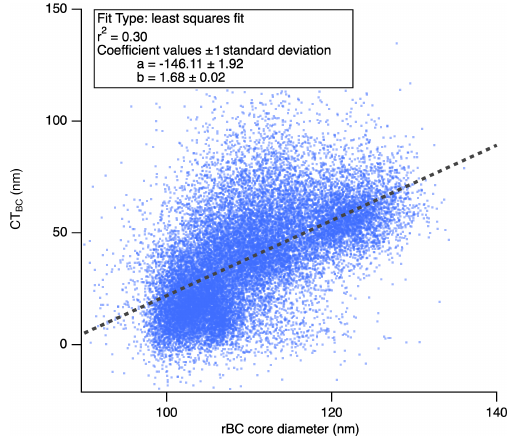
Figure 13. The rBC coating thickness versus the rBC core diame- ter. Each point on the plot represents a 1min mean. Data from all three campaigns are shown. CT BC values are calculated for parti- cles with rBC core diameters between 200 and 250nm. The line represents the least squares linear regression to the 1min mean data points. There is a statistically significant positive correlation shown between CT BC and the rBC core diameter, as shown in the summary box in the top left corner. The coefficient values a and b represent the y intercept and slope of the least squares fit,